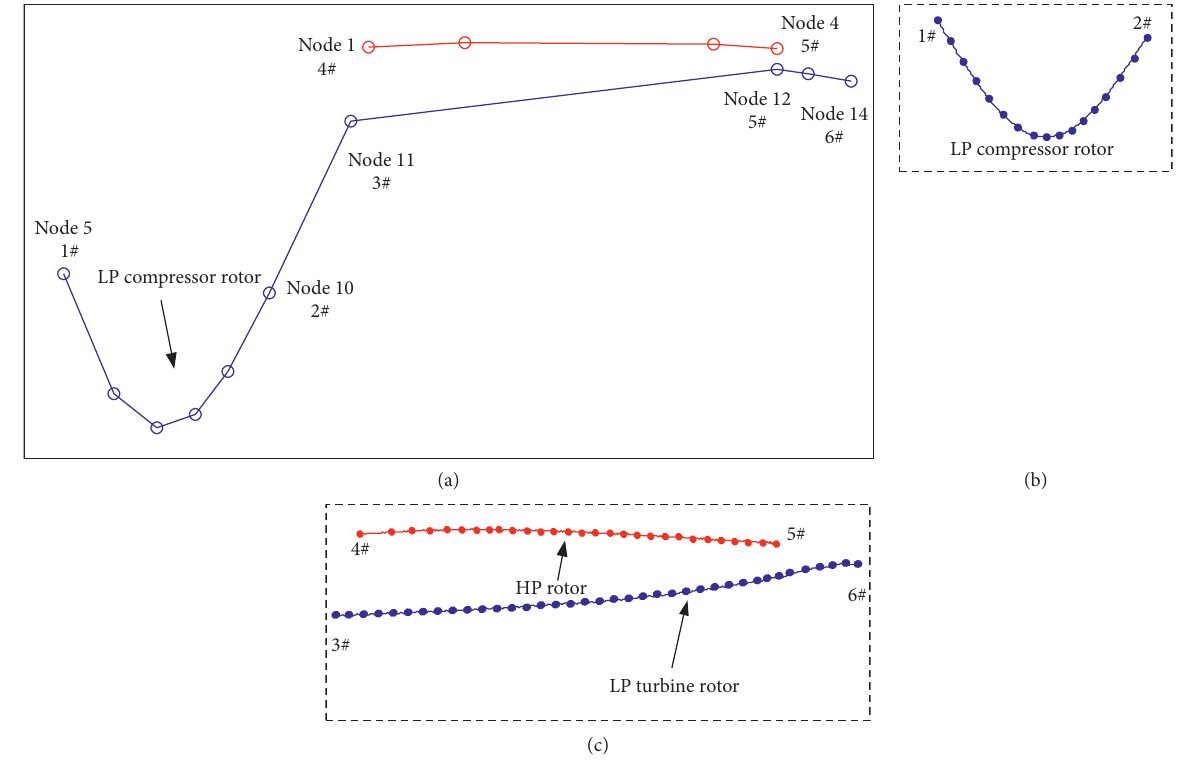
Figure 14: Modal shapes (a) for original dynamical model in Figure 3 at the second critical speed ω , and (c) for separated dual-rotor system in Figure 11 at ω A Figure 11 at ω A 1 Figure